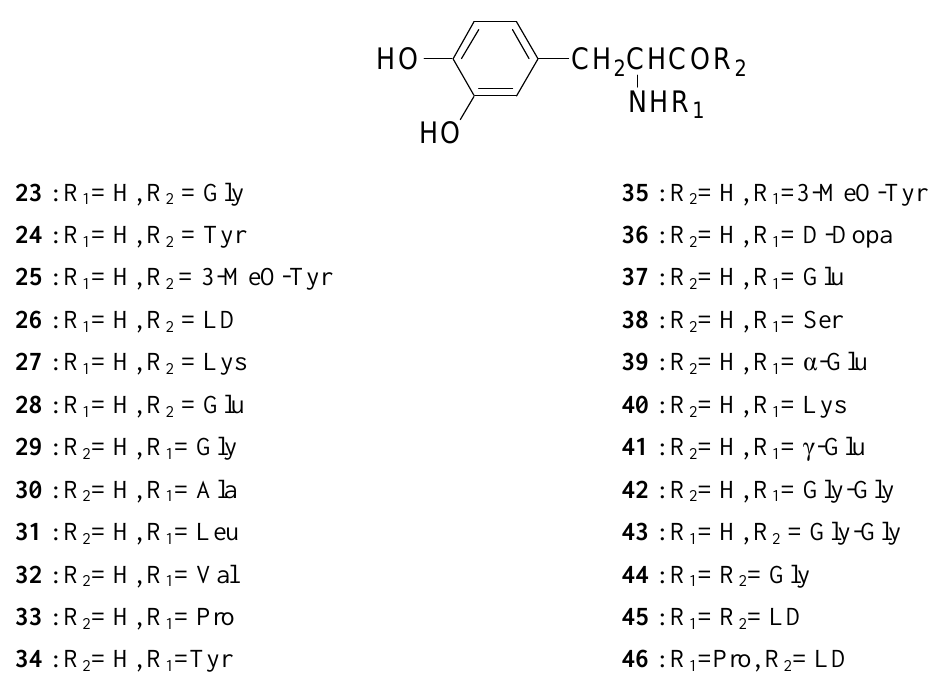
Figure 4 . Chemical structures of di- and tripeptides of